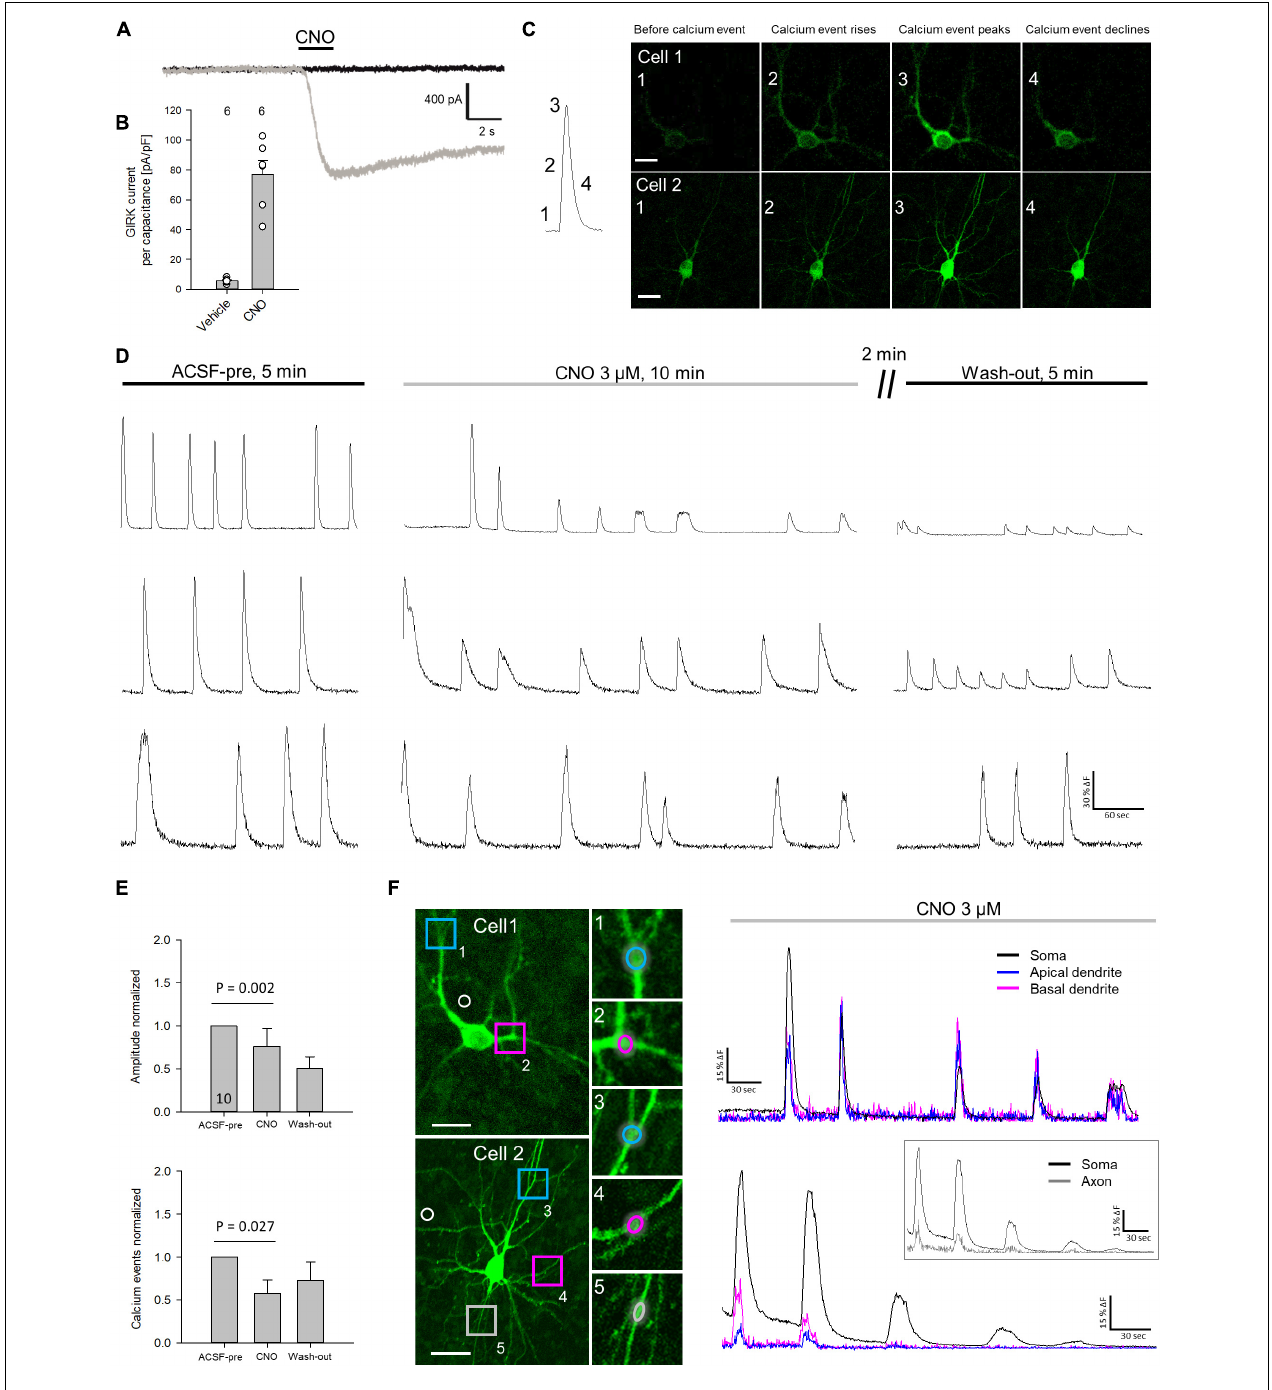
FIGURE 2 | Activation of hM4Di reduces neuronal activity. (A) Representative recording of a HA-hM4Di-transfected HEK cell after CNO application. (B) Measurement of GIRK channel-mediated currents after hM4Di activation normalized to cell volume. Number of analyzed cells is given above the bars. (C) Representative calcium event. The numbers indicate baseline activity (1), and the rise (2), peak (3), and decline (4) of a spontaneous calcium event. Representative images of calcium events of two mCherry-hM4Di/GCaMP6m transfected neurons (cells 1, 2). (D) Representative traces of spontaneous calcium events of three selected neurons recorded between DIV 15 and 20. Spontaneous calcium events were measured for 5 min in ACSF, followed by 10 min recording under 3 µ M CNO, and 5 min after wash-out. (E) Quantitative analysis (mean ± s.e.m.) of somatically recorded calcium event amplitude and frequency in ACSF under CNO and after wash-out. Number of analyzed neurons (DIV 10–20) are given in the bar. (F) Analysis of calcium events under CNO application in soma, apical and basal dendrites of cell 1, and soma, dendrites and axon of cell 2. ROIs are indicated; white circles indicate ROIs used for subtraction of background fluorescence. Statistics: Anova on ranks, ACSF-pre vs. CNO. Scale bars: 25 µ m in panel (C) , and cell overviews in panel (F) .